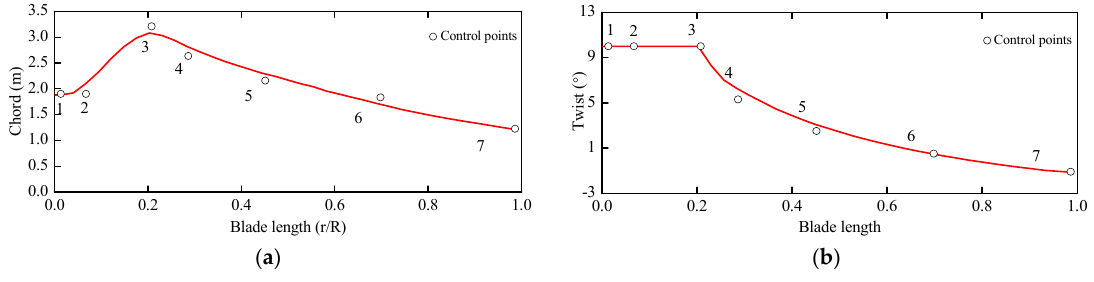
Figure 2. ( a ) Chord and ( b ) twist distribution of the blade.